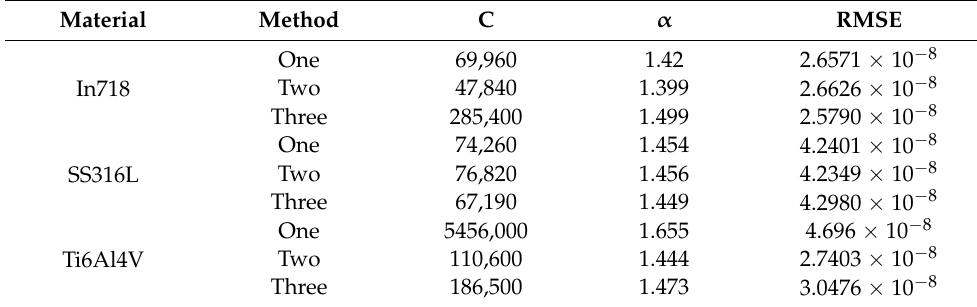
Table 3. Fitting parameters calculation for In718, SS316L and Ti6Al4V.